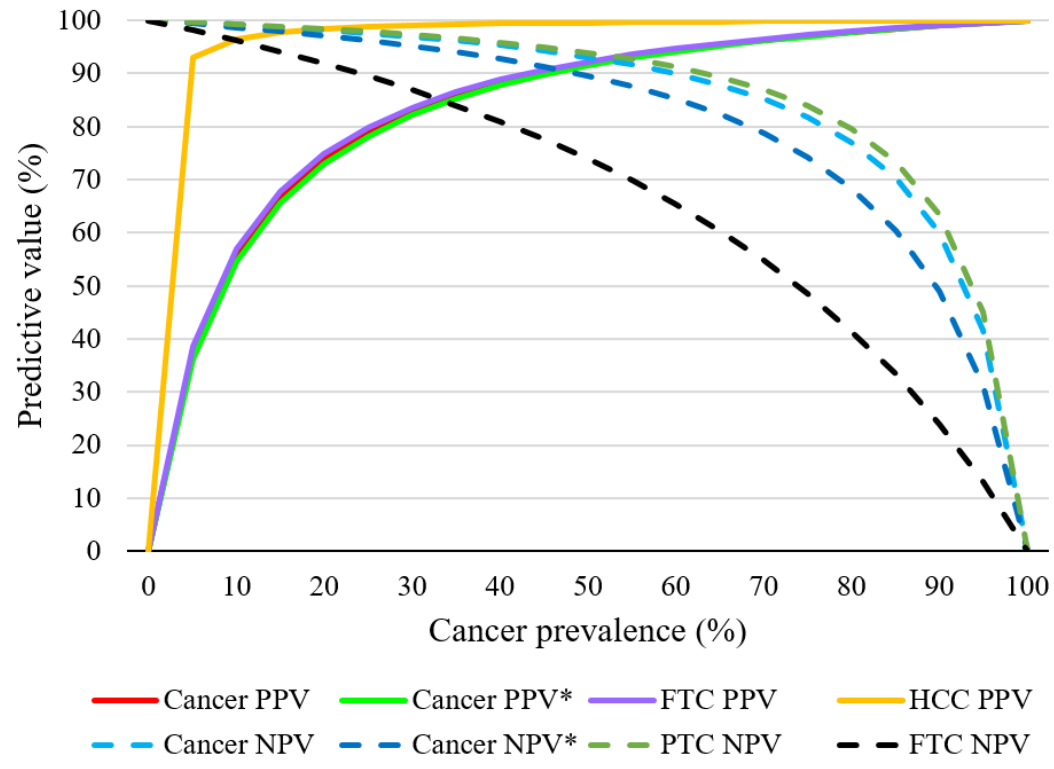
Figure 6. Expected PPV and NPV according to the sensitivity and specificity observed in the present study versus thyroid cancer prevalence in a given study population. Cancer PPV*/NPV*: with the addition of ATC and NIFTP specimens into the analyzed group.